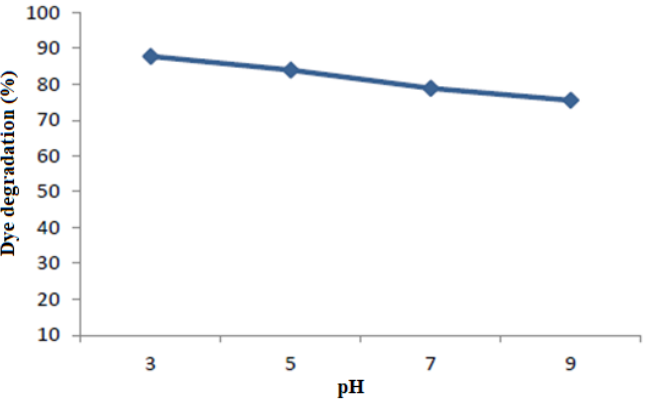
Figure 7. Effect of pH on the degradation of Reactive Yellow 160A (TiO 2 = 450 mg/L, RY ‐ 160A = 30 mg/L, H 2 O 2 = 0.8 mL, irradiation time = 120